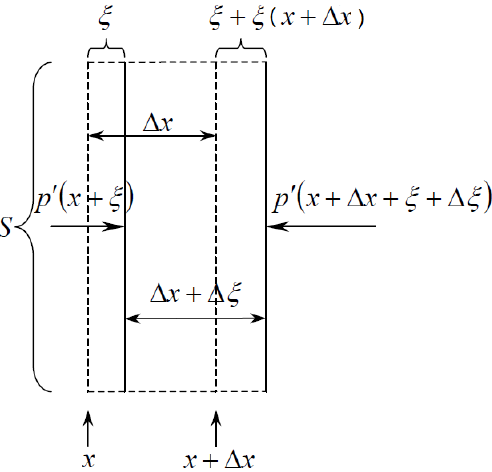
Figure 1. A volume of gas in the form of a cylinder with base area S and height Δ